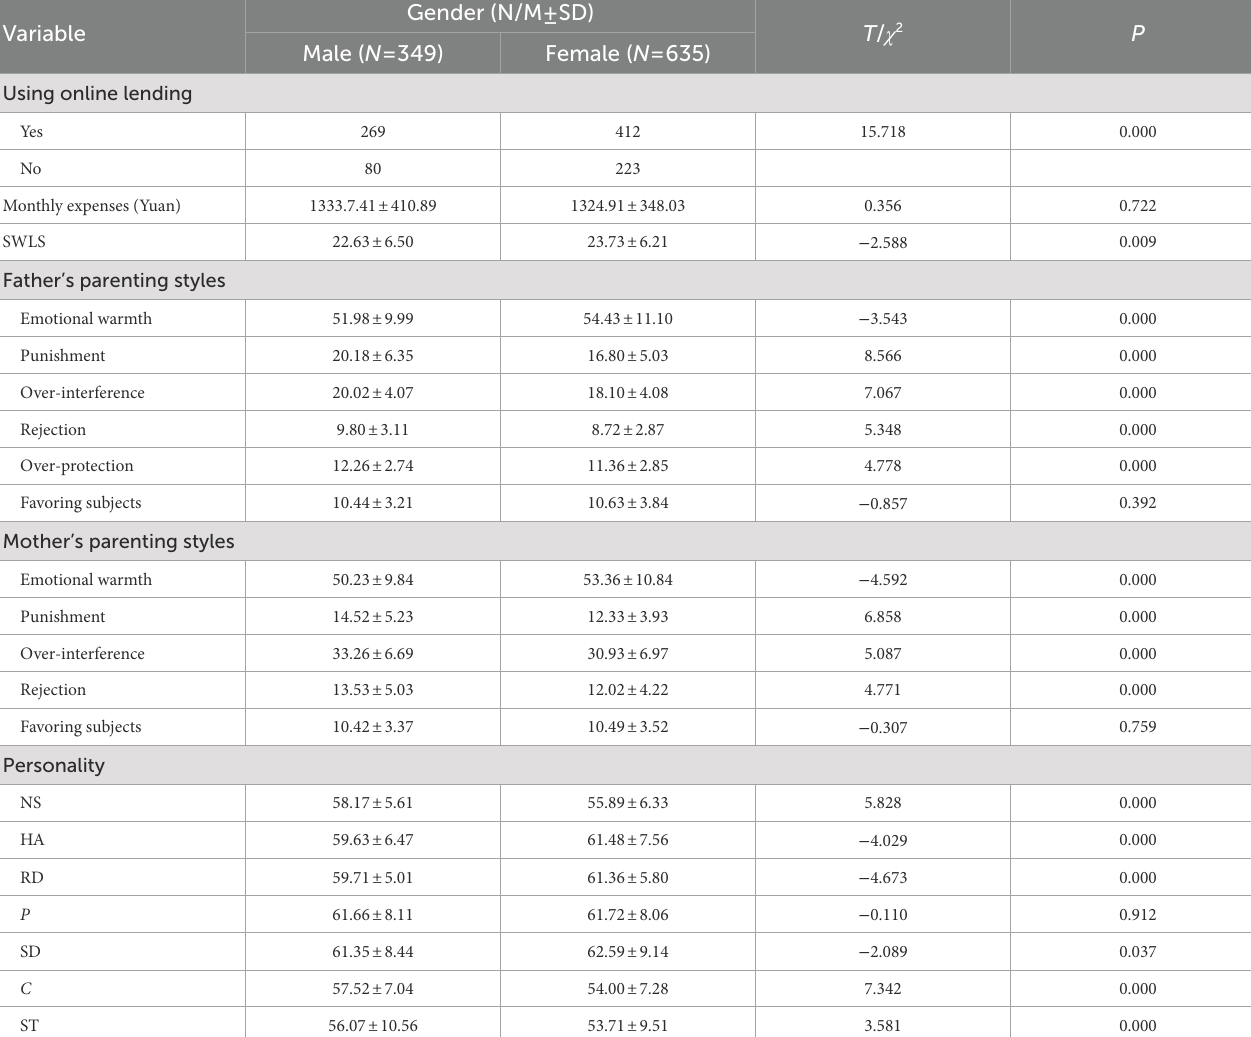
TABLE 3 Comparisons of variables between different